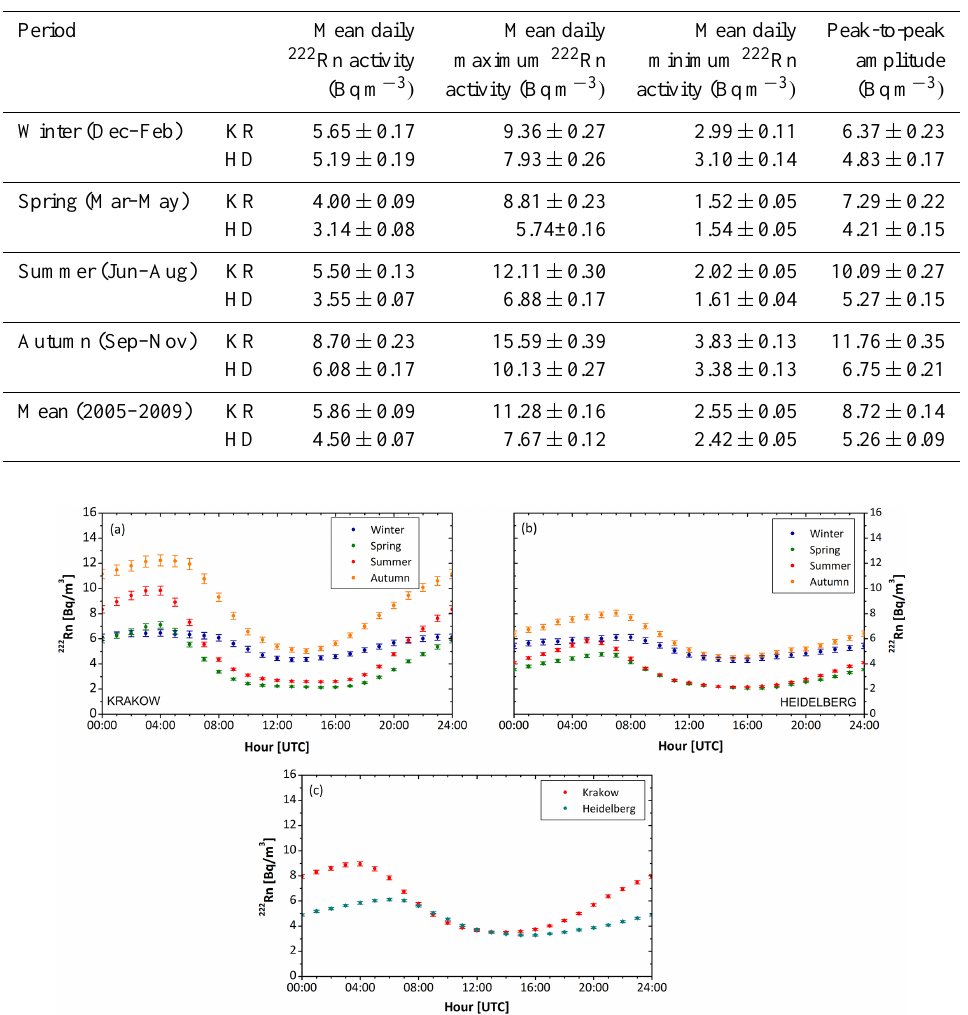
Figure 2. Diurnal variations of 222 Rn concentration in the near-ground atmosphere over Krakow (a) and Heidelberg (b) during the period January 2005–December 2009, averaged separately for each hour and for four seasons: winter (DJF), spring (MAM), summer (JJA) and autumn (SON). Diurnal variation of 222 Rn content at both sites averaged for the entire observation period is also shown (c) . Vertical marks accompanying the data points indicate standard uncertainties of the calculated mean